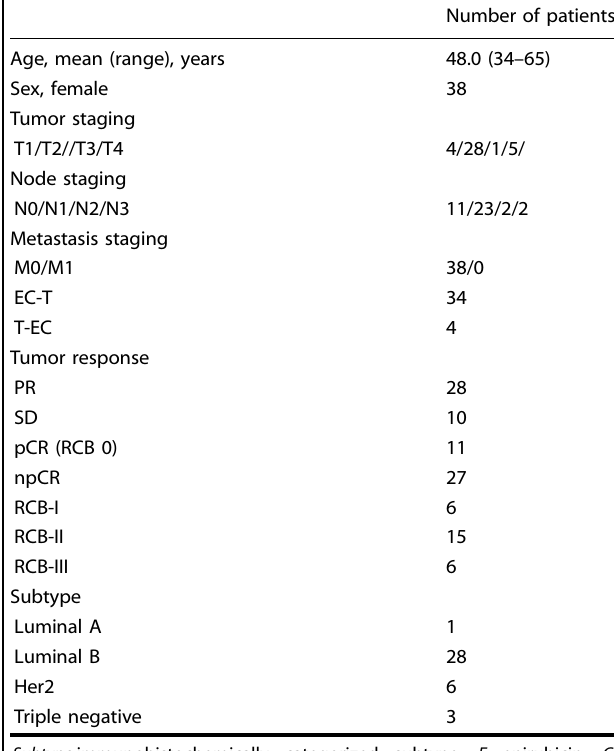
Table 2. Clinical characteristics of the 38 breast cancer patients undergoing neoadjuvant chemotherapy in the